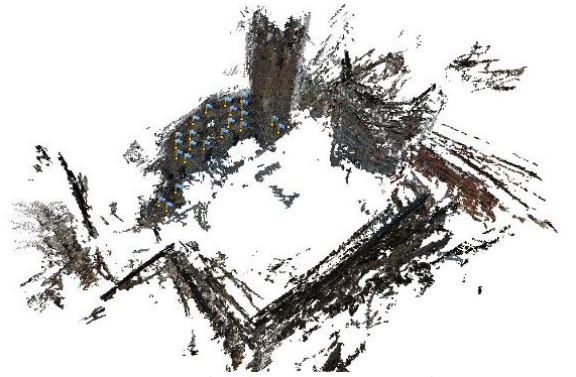
Figure 6. Example of shifts between subset of dense points.